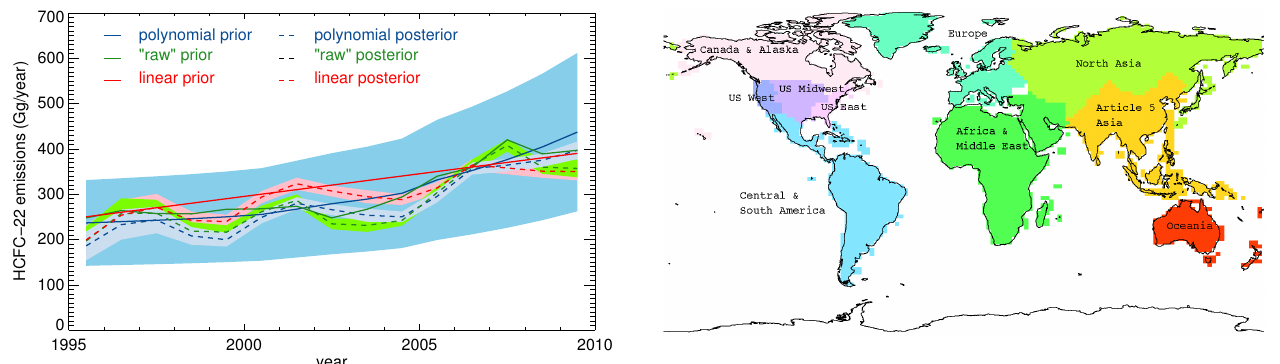
Fig. 5. 10 regions for which we derive emissions between 2005 and 2009 in our regional inversion. 36